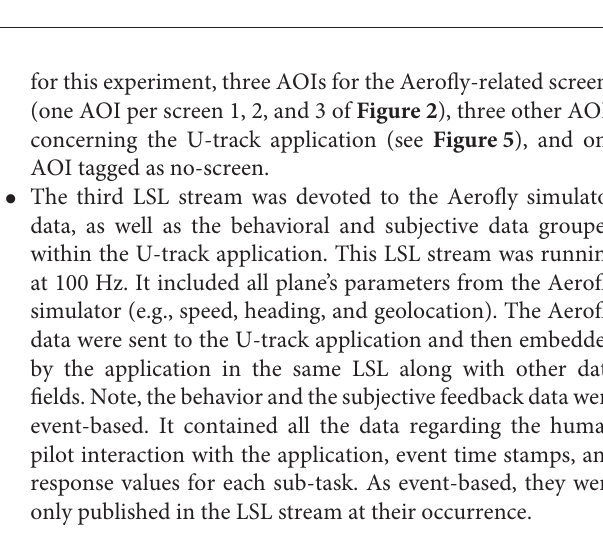
FIGURE 4 | Pre-processing, feature extraction, and classification